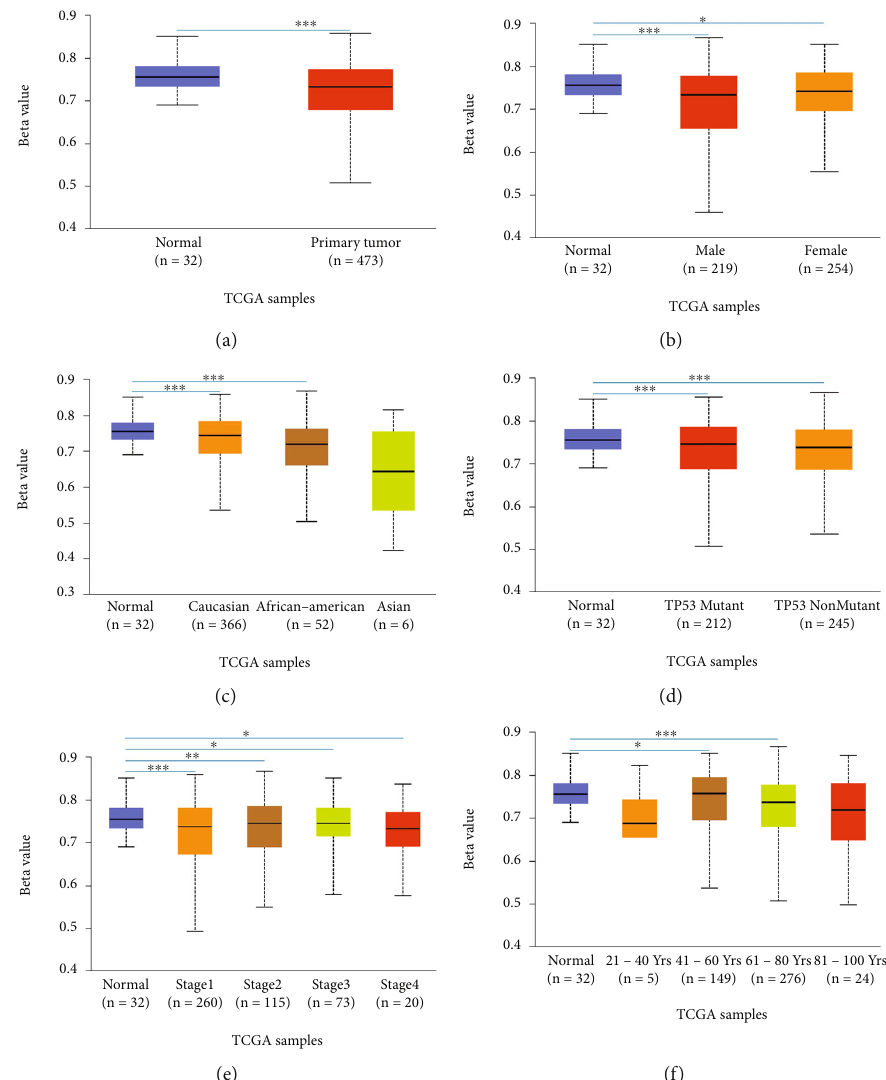
Figure 5: Promoter methylation levels of SLC2A5 in LUAD. Promoter methylation levels of SLC2A5 were low in (a) – (f). LUAD: (a) sample type, (b) gender, (c) race, (d) TP53 mutation status, (e) individual cancer stages, and (f) age ( ∗ P < 0 : 05 , ∗∗ P < 0 : 01 , and ∗∗∗ P < 0 : 001